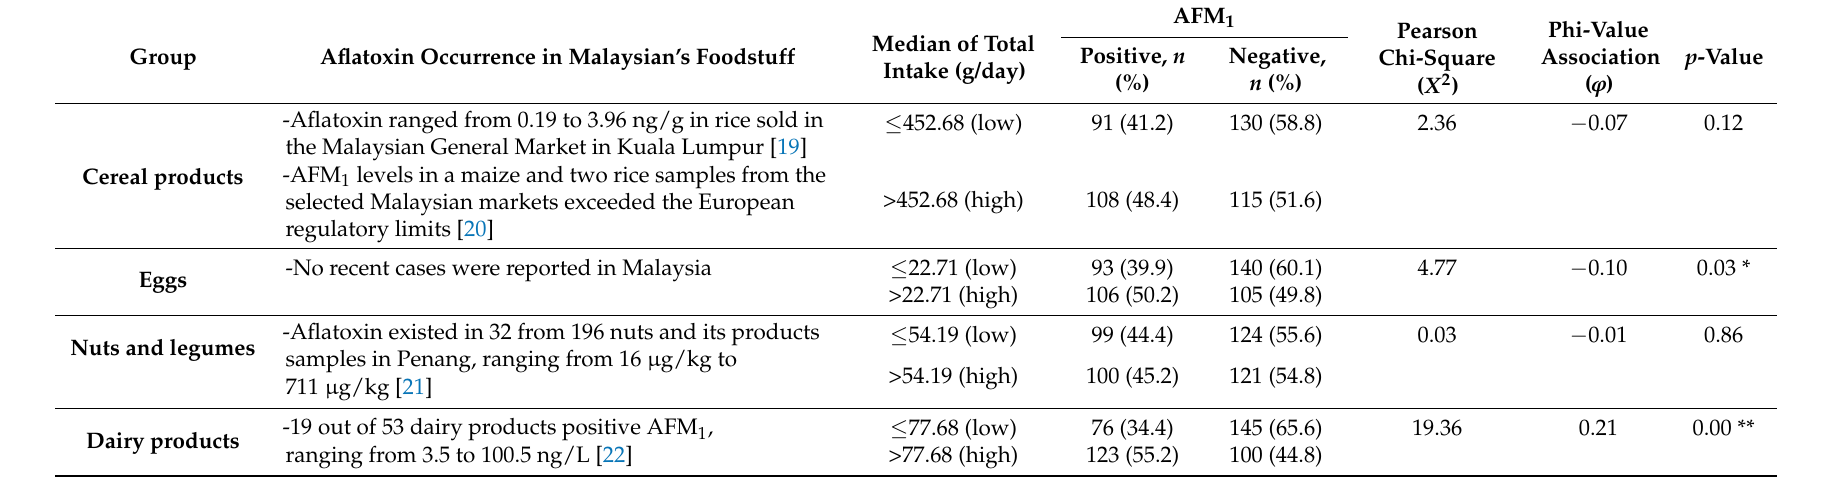
Table 3. Aflatoxin occurrences in Malaysians’ foodstuff and the Chi-Square analyses on the association between dietary intake level and AFM 1 biomarker presence among respondents a